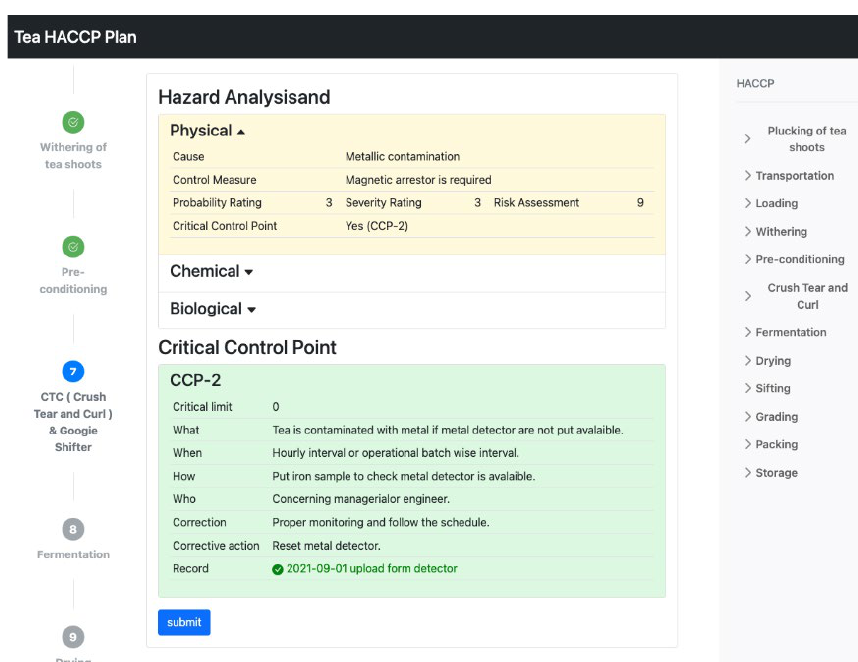
Figure 15. The system implementation of the HACCP audit.